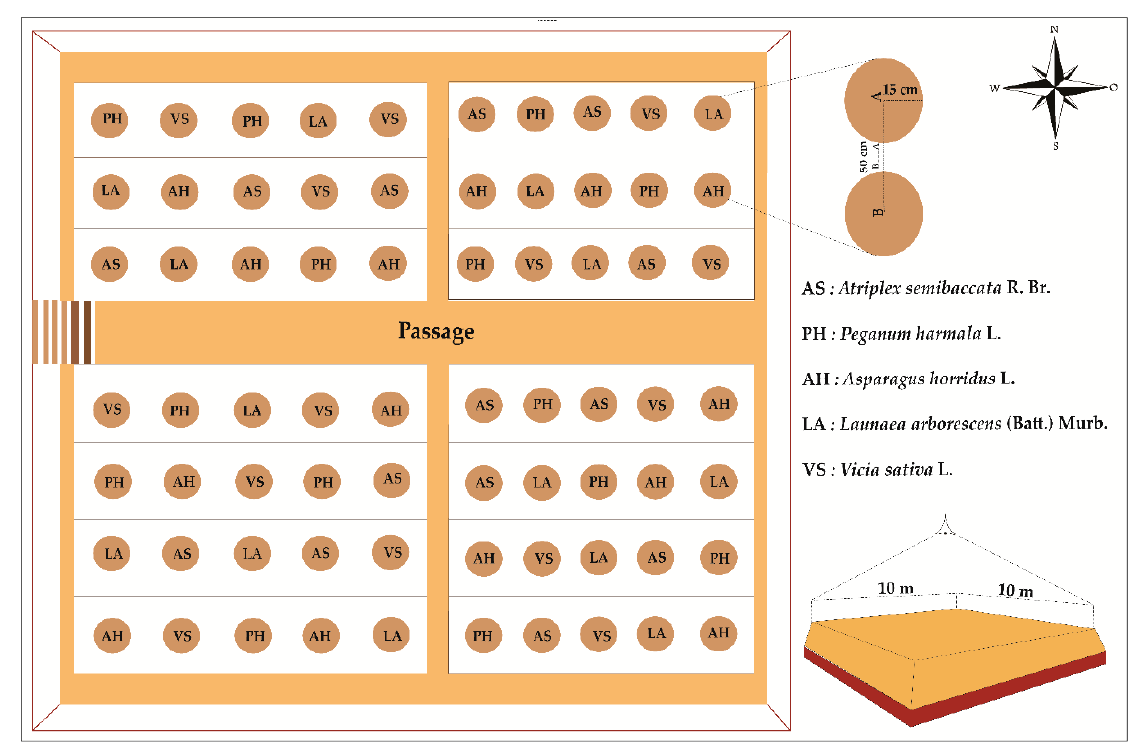
Figure 2. Schema of the experimental plot used to conduct the study.